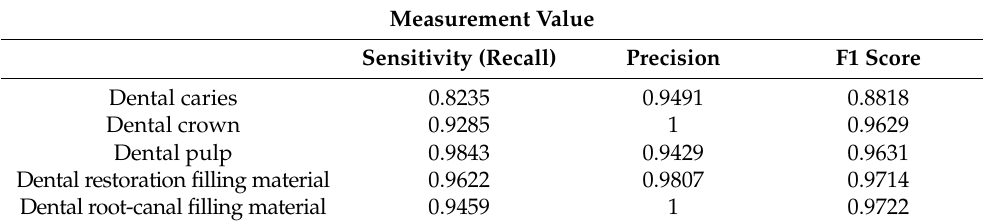
Figure 3. Estimated segmentation images created by AI model. ( a ). Estimated image for dental caries. ( b ). Estimated image for the dental crown. ( c ). Estimated image for a dental pulp. ( d ). Dental restoration filling material. ( e ). Dental root-canal filling material. Table 2. The value of AI model estimation performance measurement using the confusion